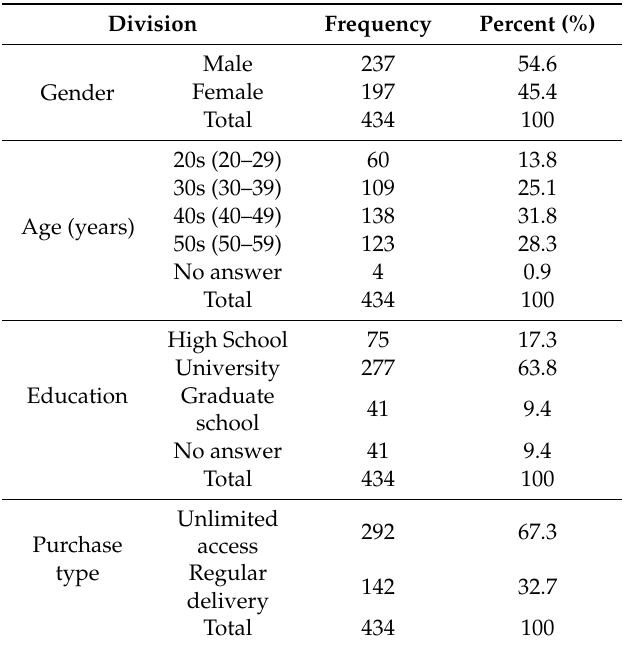
Table 2. Demographic breakdown of survey